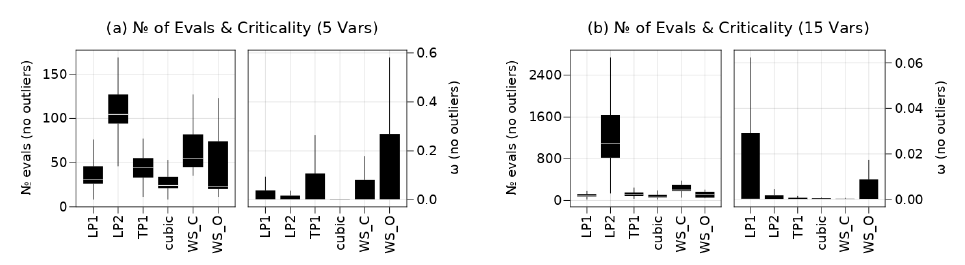
Figure 4. Box-plots of the number of evaluations and the solution criticality for n = 5 and n = 15 for the runs from Figure 3. Outliers are not shown. “WS_C” and “WS_O” refer to the weighted sum approach using COBYLA and ORBIT ,